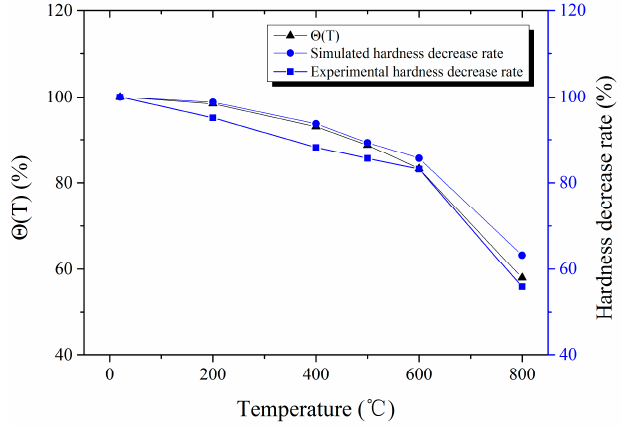
Figure 14. The comparison of experimental hardness decrease rate and Θ ( T ).